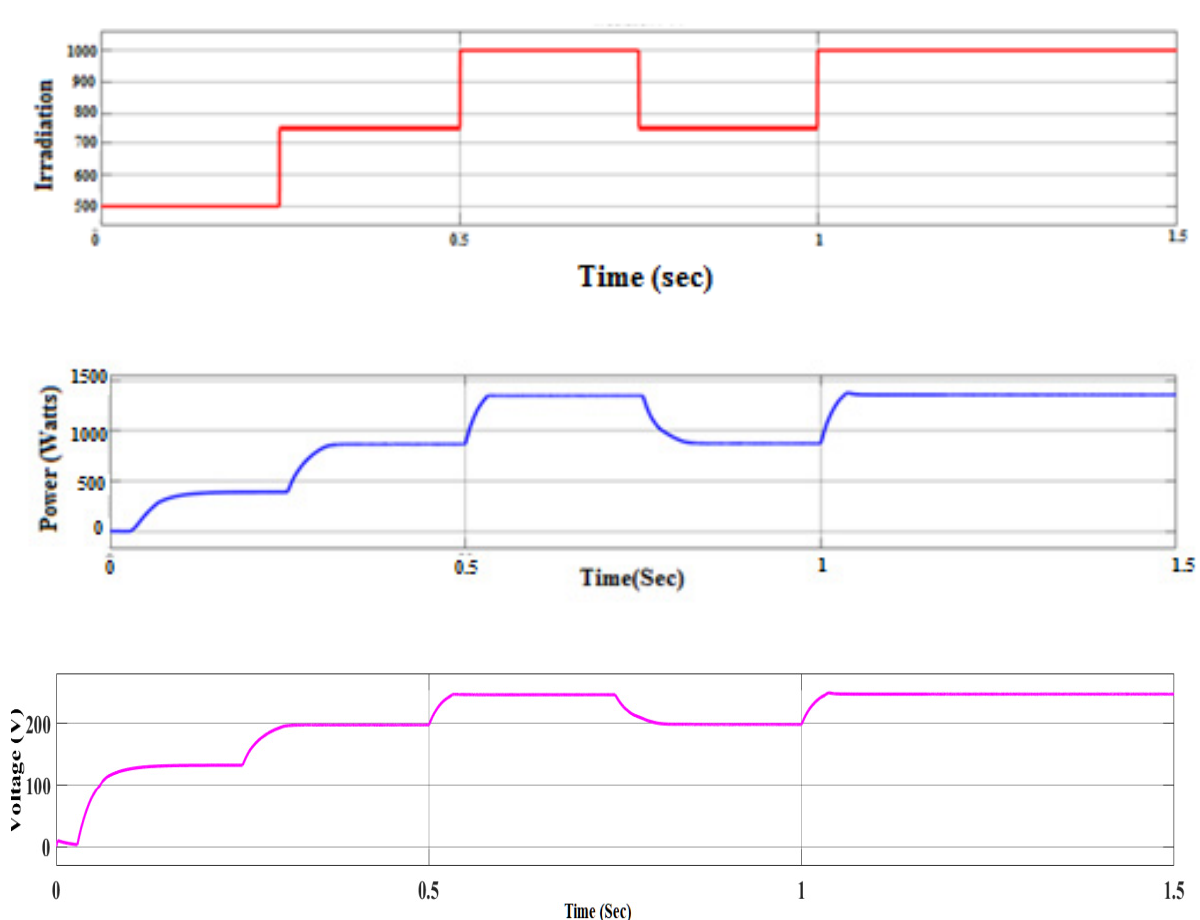
Figure 5. Output PV power and converter voltage with respect to irradiance.